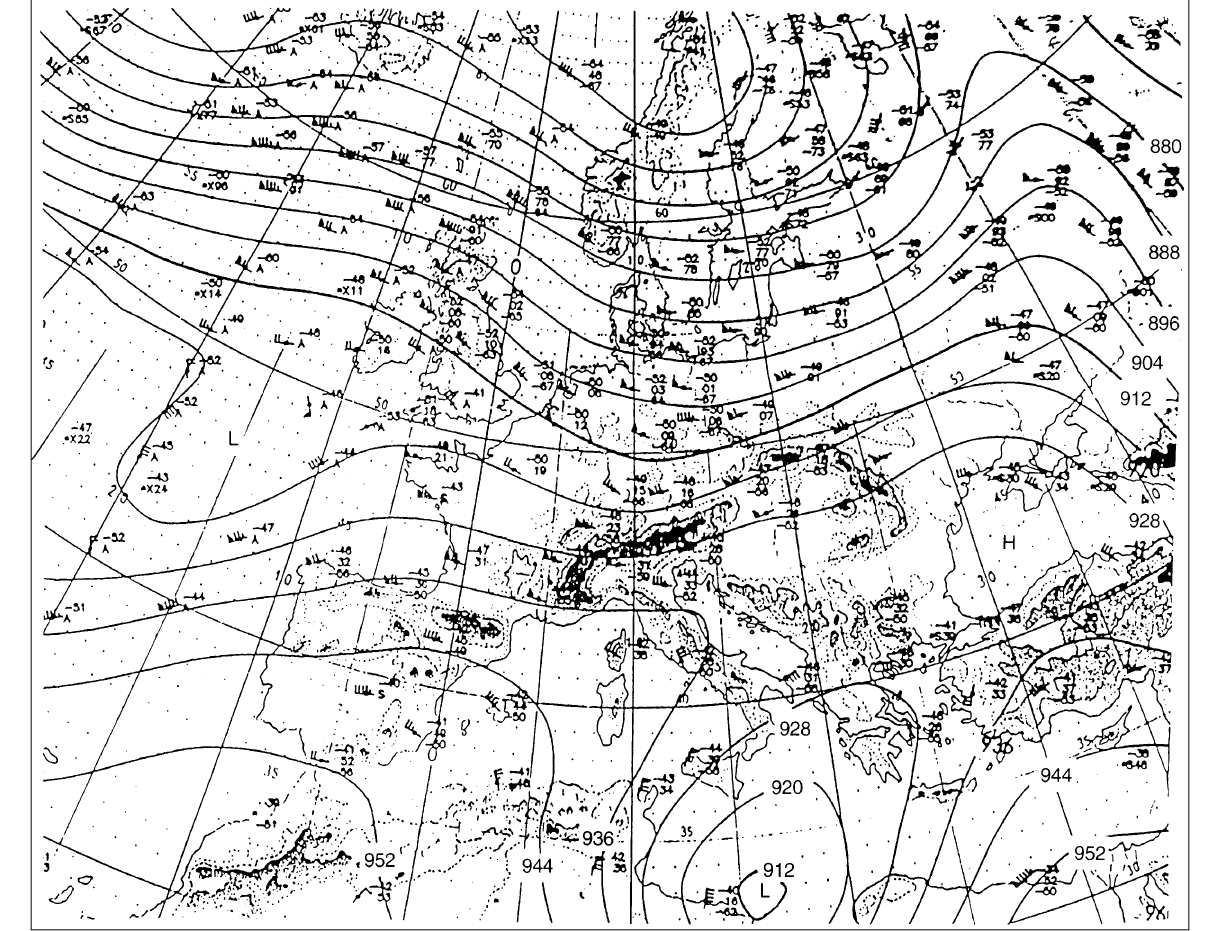
Fig. 10. 5 December 1993; 300-hPa map (Courtesy of European Meteorological Bulletin, Germany)